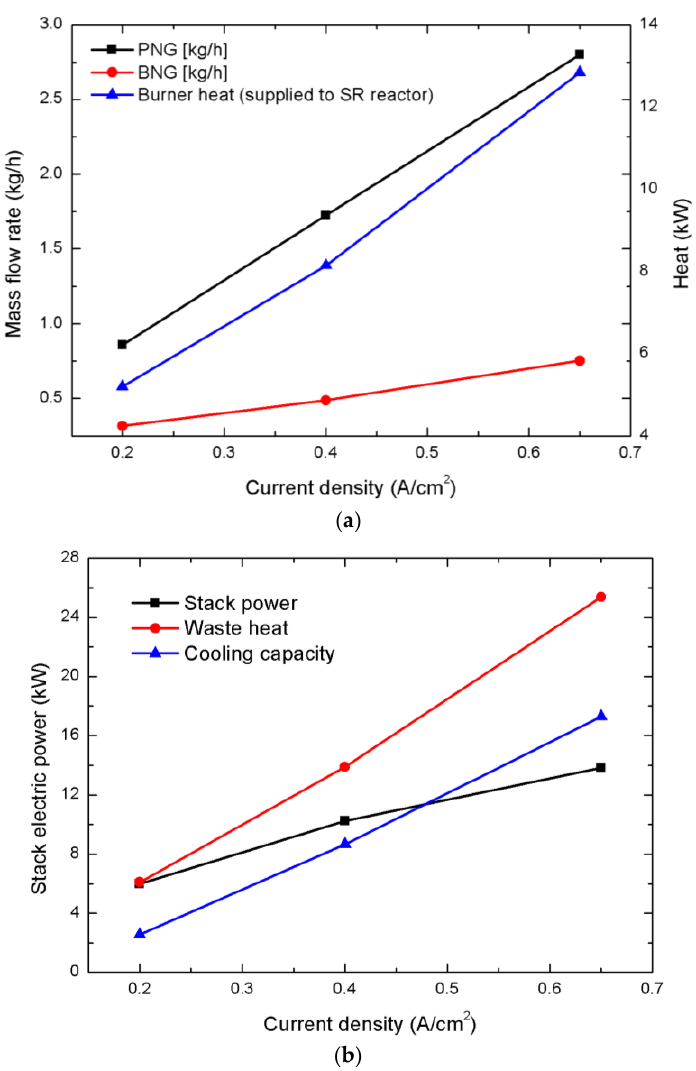
Figure 8. ( a ) Required burner natural gas (BNG) and process natural gas (PNG) flow rates and amount of heat supplied to the SR reactor with the variation of operating current density, ( b ) electric power, waste heat, and cooling capacity of HT-PEMFC stack as a function of operating current density. As the operating current density varied, the BNG and PNG flow rates were adjusted to maintain the same anode stoichiometry of 1.2.